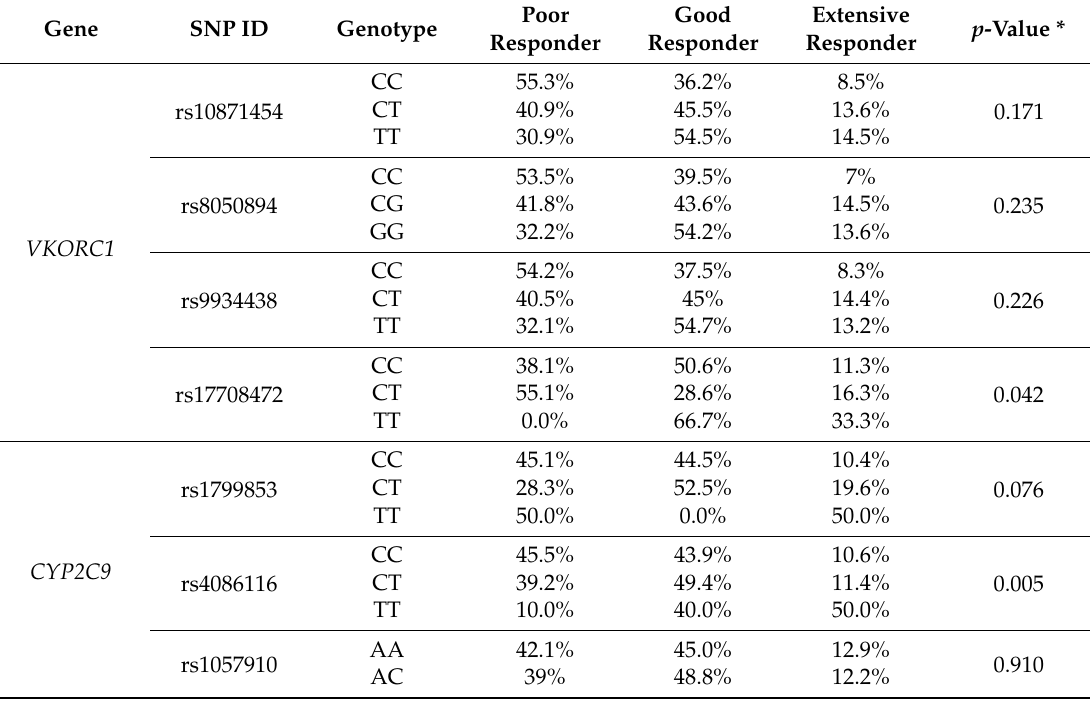
Table 5. Association of VKORC1 and CYP2C9 SNPs with response to warfarin during the initiation phase of therapy of 212 cardiovascular patients.